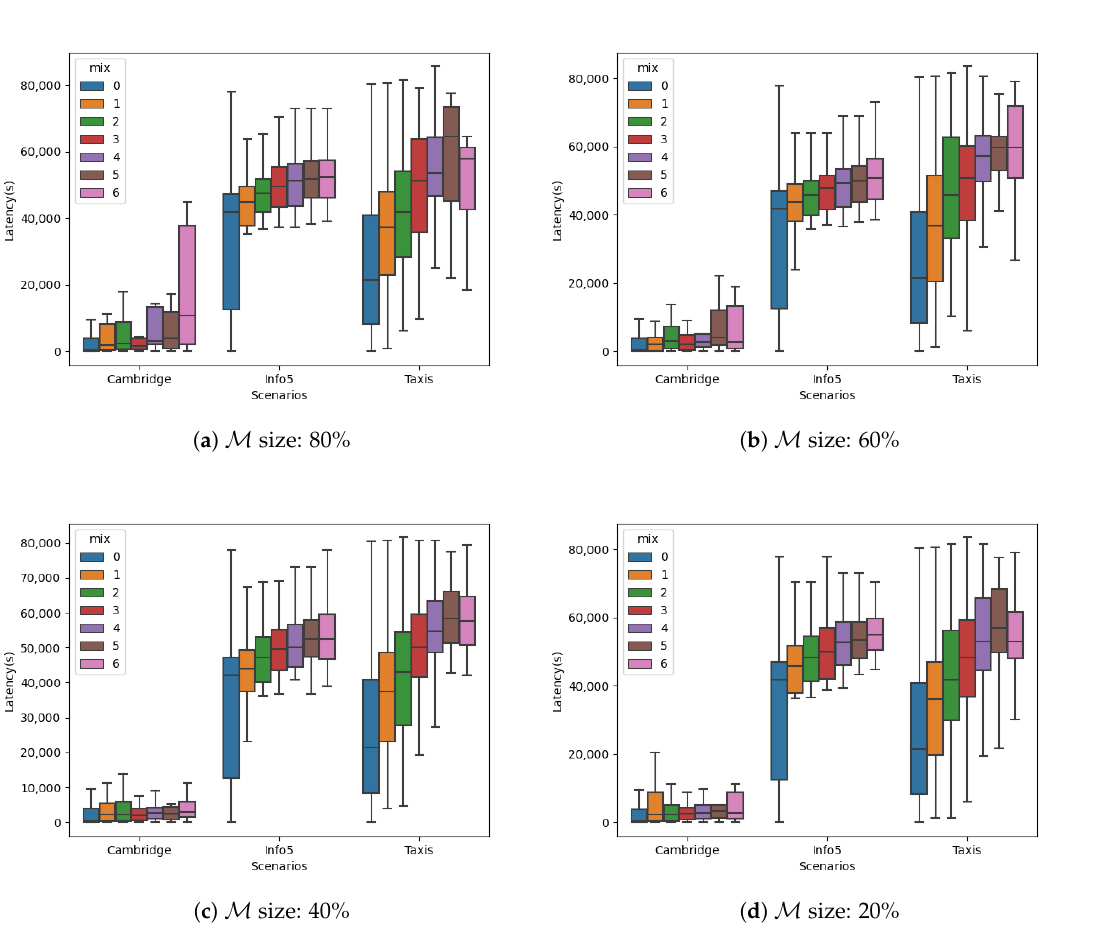
Figure 5. Latency with centrality mix nodes. Table 2. Overhead ratio with random mix